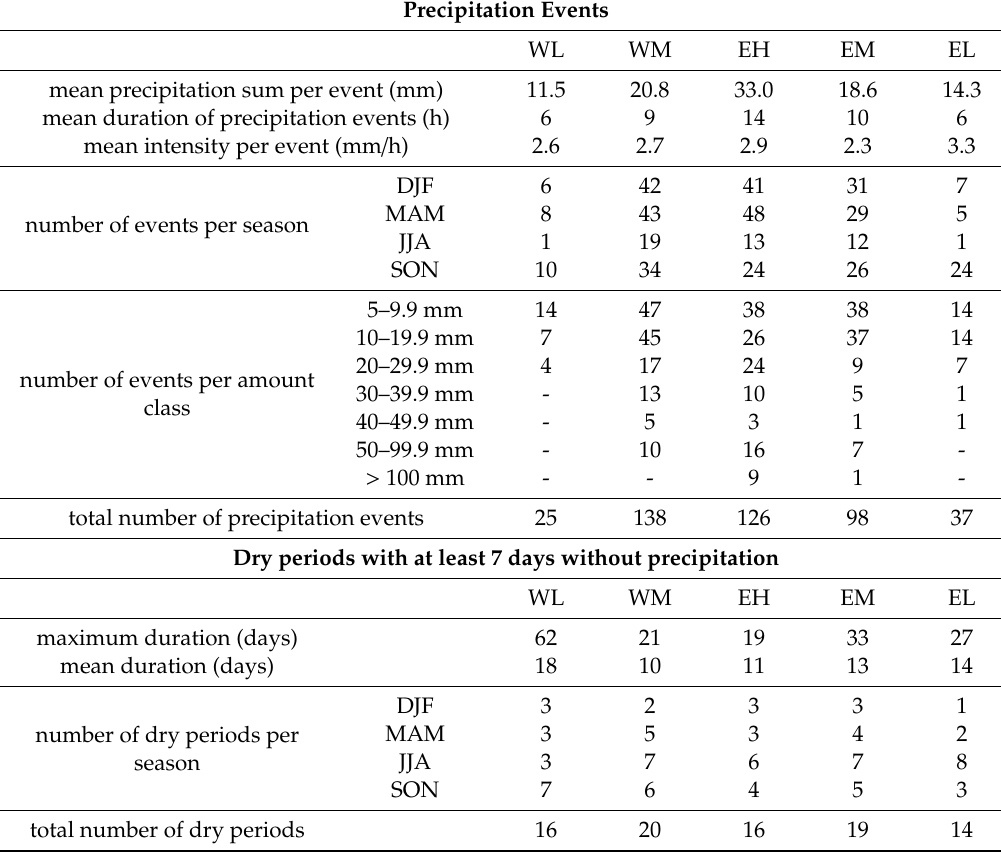
Table 2. Characteristics of precipitation events and dry periods between May 2017 and April 2019. Mean precipitation sum was calculated independent from the mean duration of the events. Site codes refer to the eastern (E) and western (W) side of Corsica, L, M, and H stand for low-, middle-, and high-elevation sites, respectively. The seasons are expressed as abbreviations for the